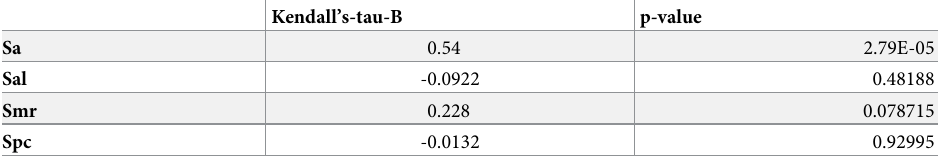
Table 4. Result of the Kendall’s tau correlation test for the four texture